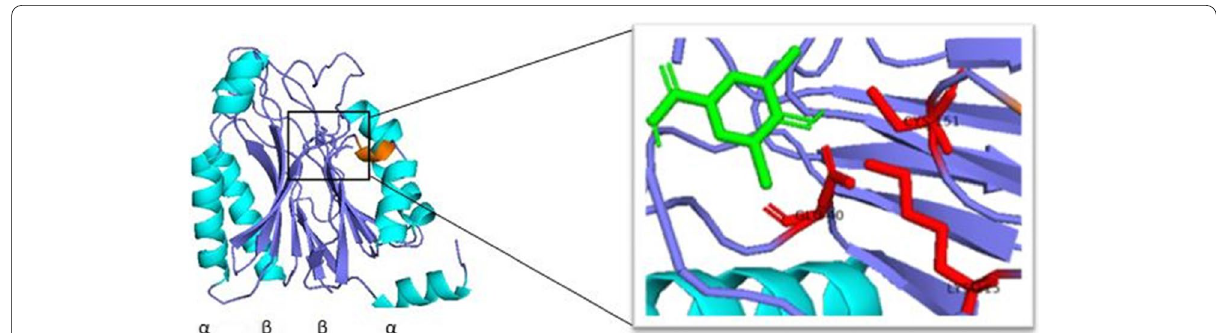
Fig. 5. Homology modeled structure of nitrilase-3 protein: catalytic triad residues highlighted in red color, alpha helix (cyans) and beta sheets (blue) are highlighted by different colors